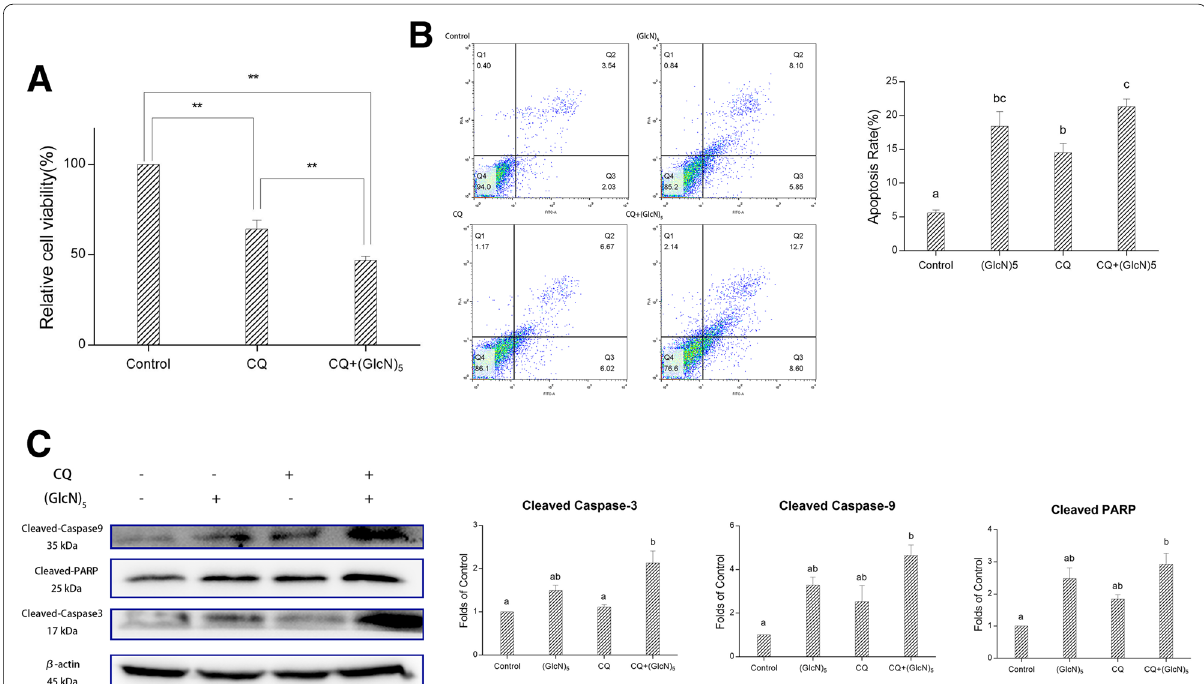
Fig. 7 (GlcN) 5 impair autophagy flux and induce apoptosis. A Cell viability detection. B Apoptosis analysis using flow cytometry. C Western blot analysis for cleaved Caspase-3, Caspase-9, and PARP. Cells were treated with or without (GlcN) 5 (5 mM), or CQ (5 μM). Data were represented as mean SD, significance between groups was marked by various letters, a, b, c, etc . (One-way ANOVA). ***, p < 0.001 ±